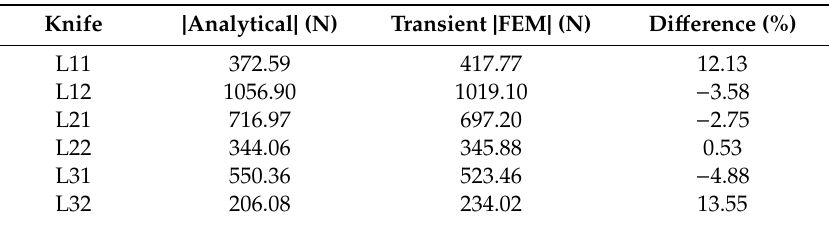
Table 5. Comparison of electrodynamical forces for transient state.